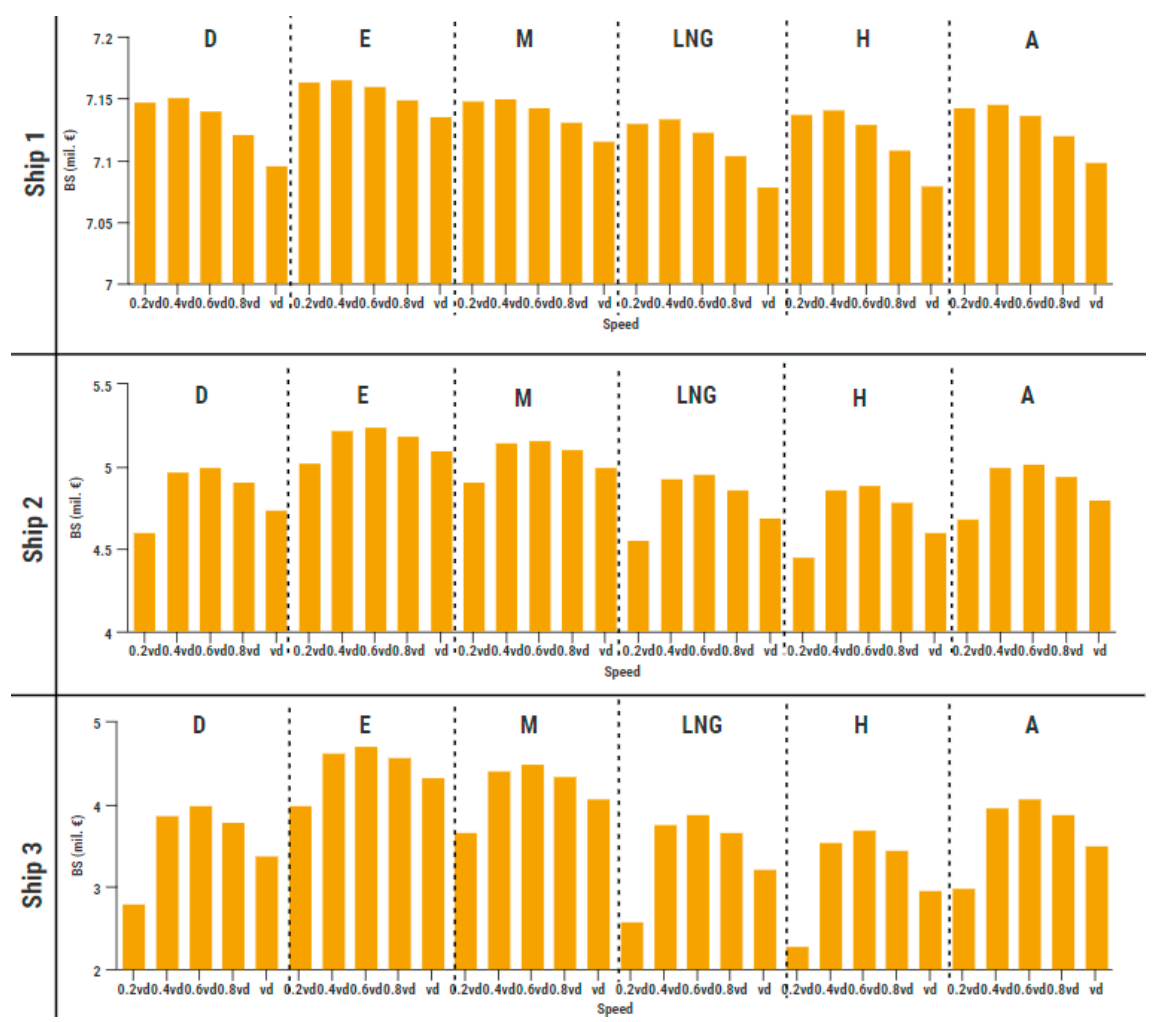
Figure 7. Impact of speed reduction on annual economic profit of ships with different power systems.